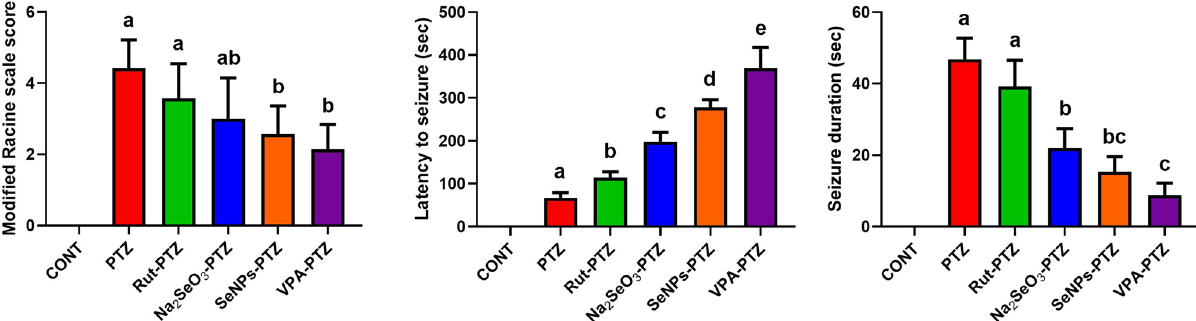
Figure 2: E ff ects of orally administered Rut, Na 2 SeO 3 , or Rut - SeNPs on PTZ - induced behavioral changes, seizure latency, and duration. Di ff erent superscript letters indicate statistical signi fi cance at P < 0.05. All results are presented as the mean ±